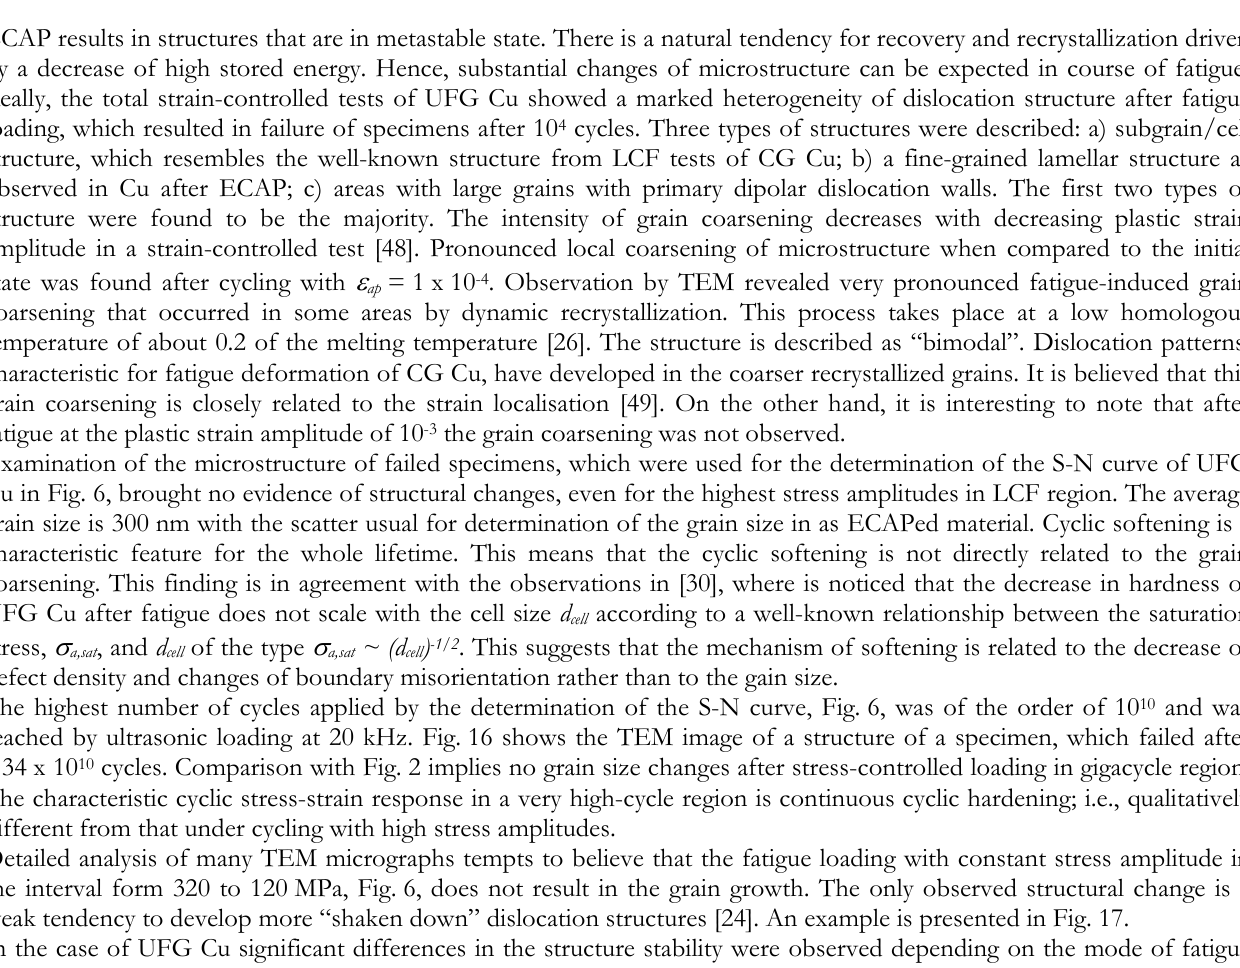
Figure 16: Microstructure after 10 10 cycles. Figure 17: Microstructure after fatigue loading exhibiting “shaken down”